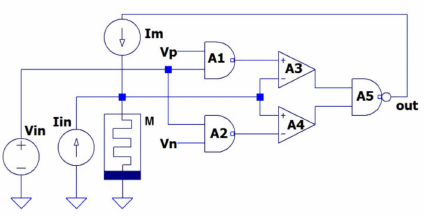
Figure 1. Schematic of the typical reactance-less memristor-based